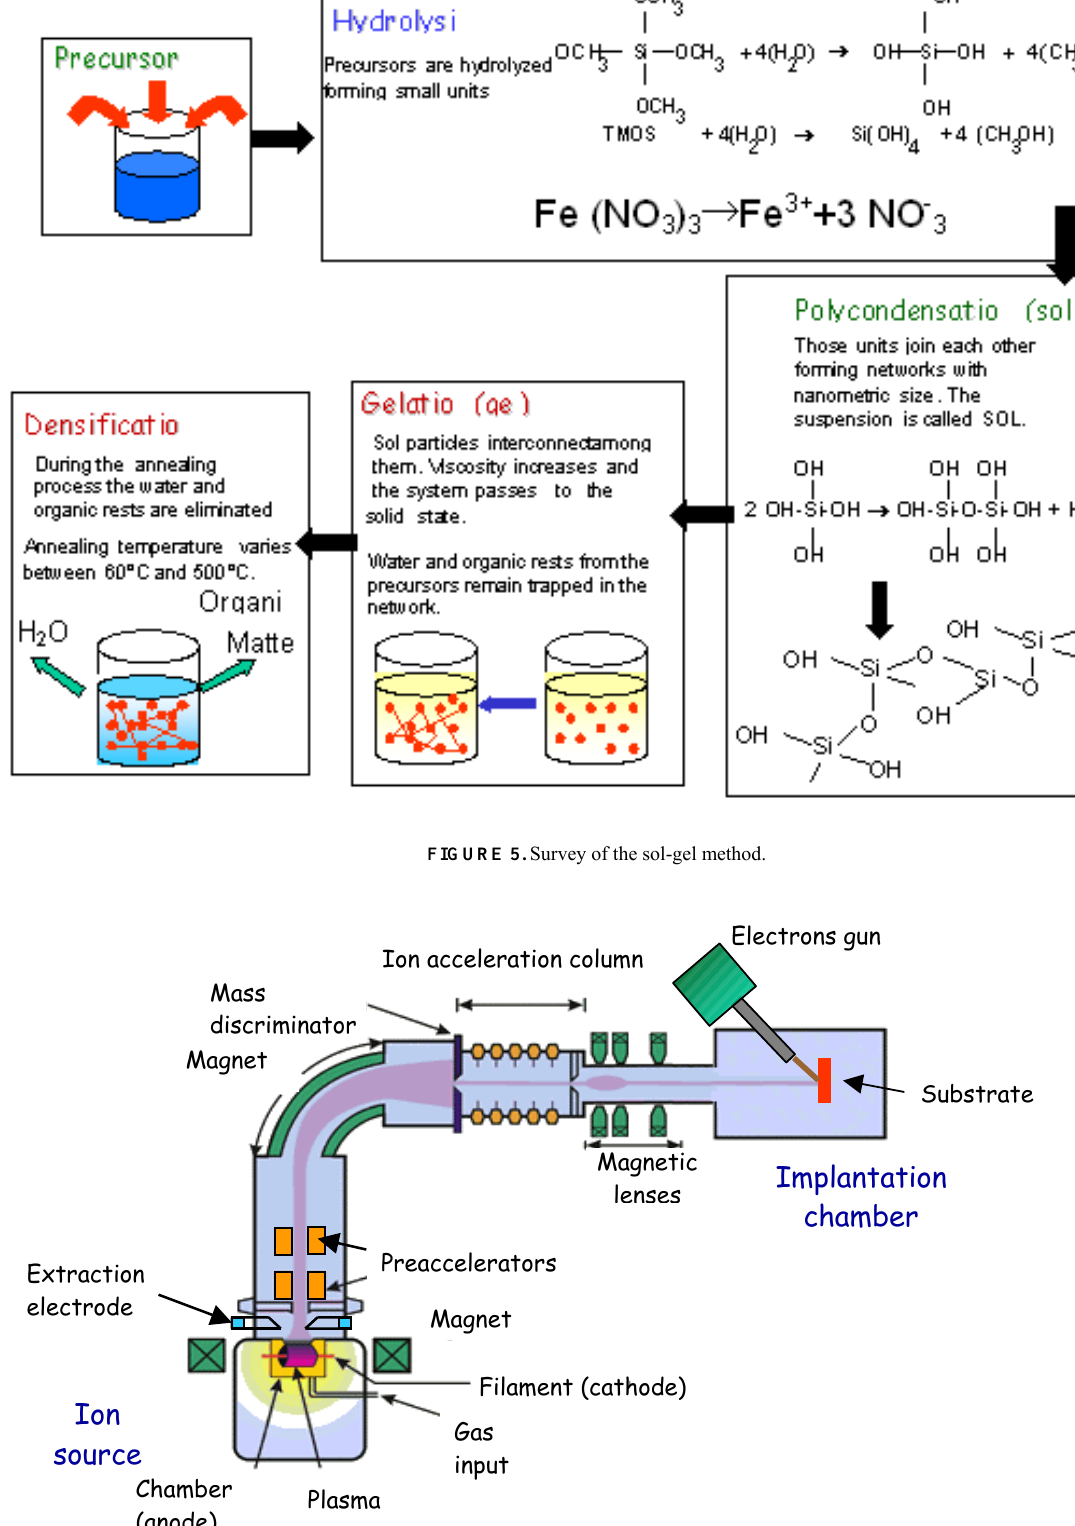
FIGURE 6. Scheme of the experimental set-up for ion